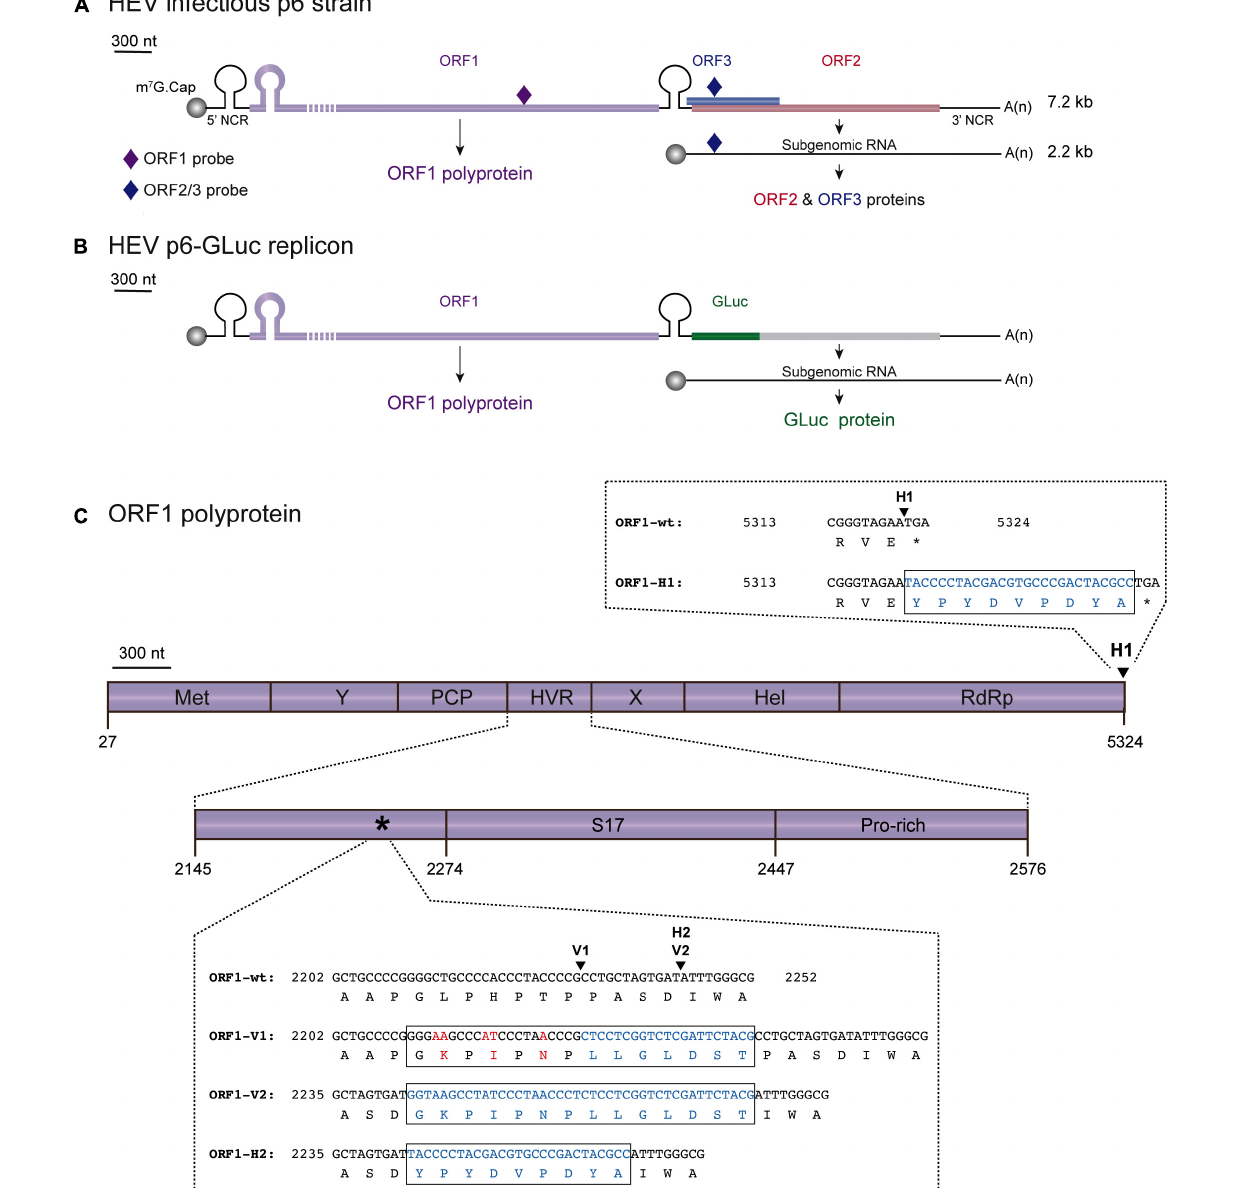
Frontiers in Microbiology |